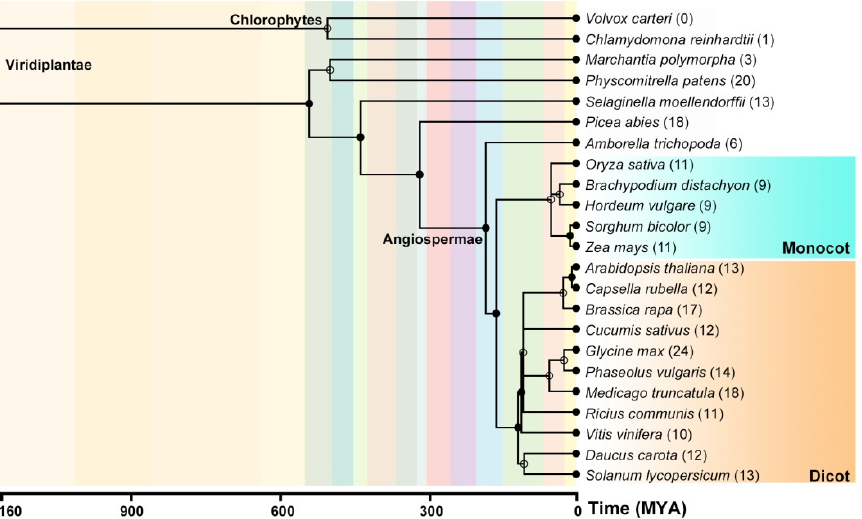
Figure 1. Phylogeny distribution of DUF506 genes across 23 species used in this study. The number of high confidence DUF506 genes is listed in parentheses. The order of tree branches and divergence time are derived from the TimeTree database (http://www.timetree.org/, accessed on August 2021). Monocot species are highlighted in the rectangle of teal color, whereas the dicot species are masked by rectangle in yellow color.